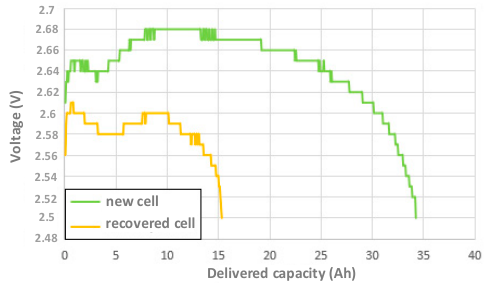
Figure 16. Voltage profile during discharge by 120 A for regenerated (yellow) and referenced cell (green).